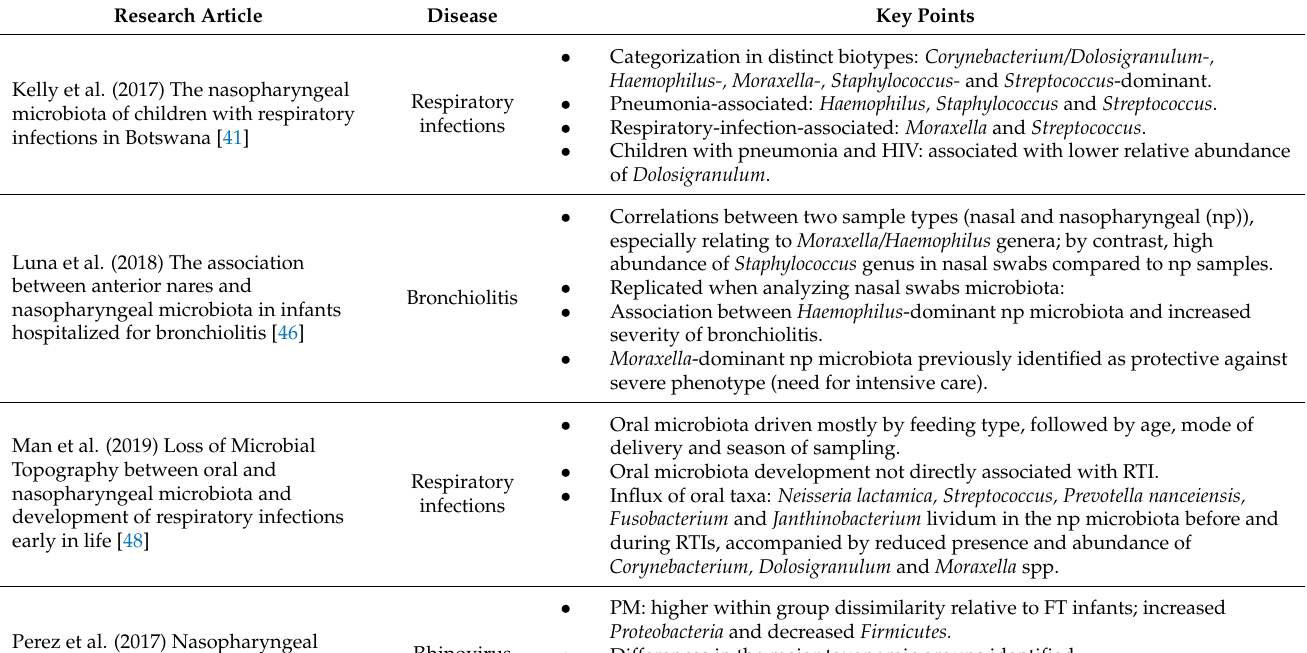
Table 2. Overview of research articles of the nasopharyngeal microbiota of the upper respiratory tract of children with asthma, exacerbation, wheezing and respiratory